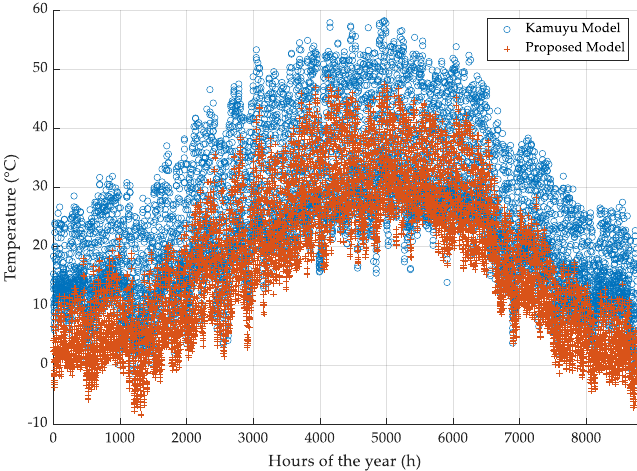
Figure 7. Operation temperature of an FPV installed on the surface of Lake Mead. ( + ) Operating temperature using the proposed model in this study for foam-based FPV. ( o ) Operating temperature using a ponton-based tilted FPV described by Kamuyu’s model.